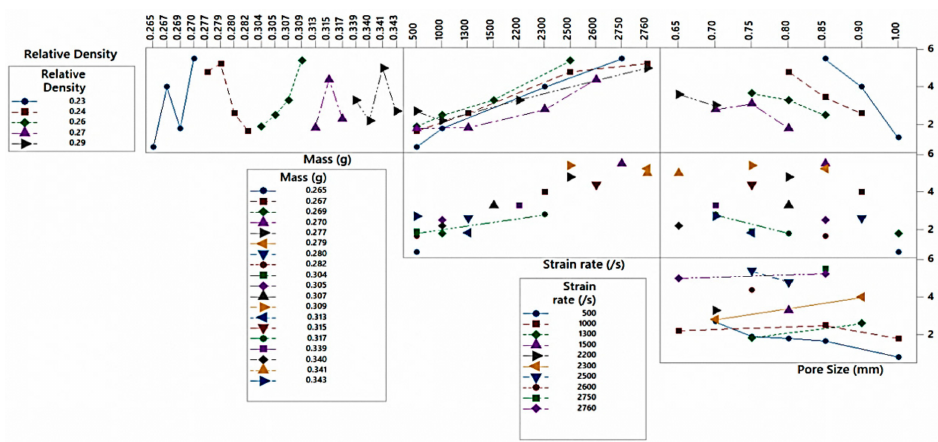
Figure 7. Main e ff ect plot for energy absorption.